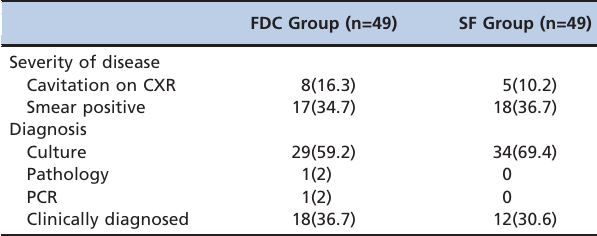
Table 4 - The severity of disease and the distribution of diagnostic